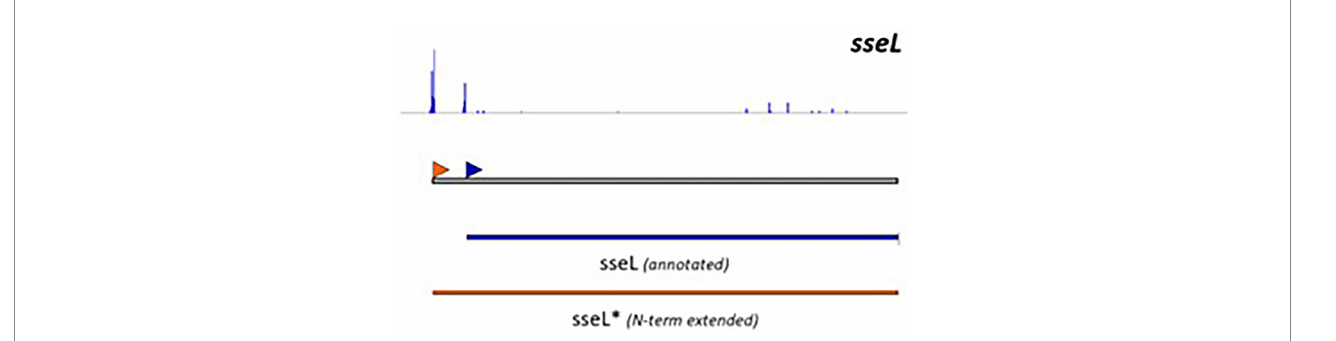
FIGURE 1 Retapamulin-assisted ribosome profiling (Ribo-RET) profile of S. typhimurium T3E SseL pointing to translation initiation at a newly identified upstream TIS. Bacterial ribosomes are specifically arrested at translation start sites by the antibiotic retapamulin. Here, translation initiation at a newly identified upstream TIS resulted in translation of an N-terminal extended SseL proteoform (Chromosome: 2392442–2393461). The annotated and newly discovered TISs are marked with a blue and orange arrowhead, respectively. Data from Fijalkowski et al.